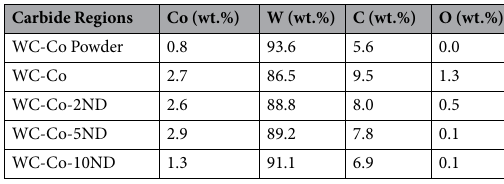
Table 4. EDS point analysis of WC particle region in powder and SPS consolidated samples.